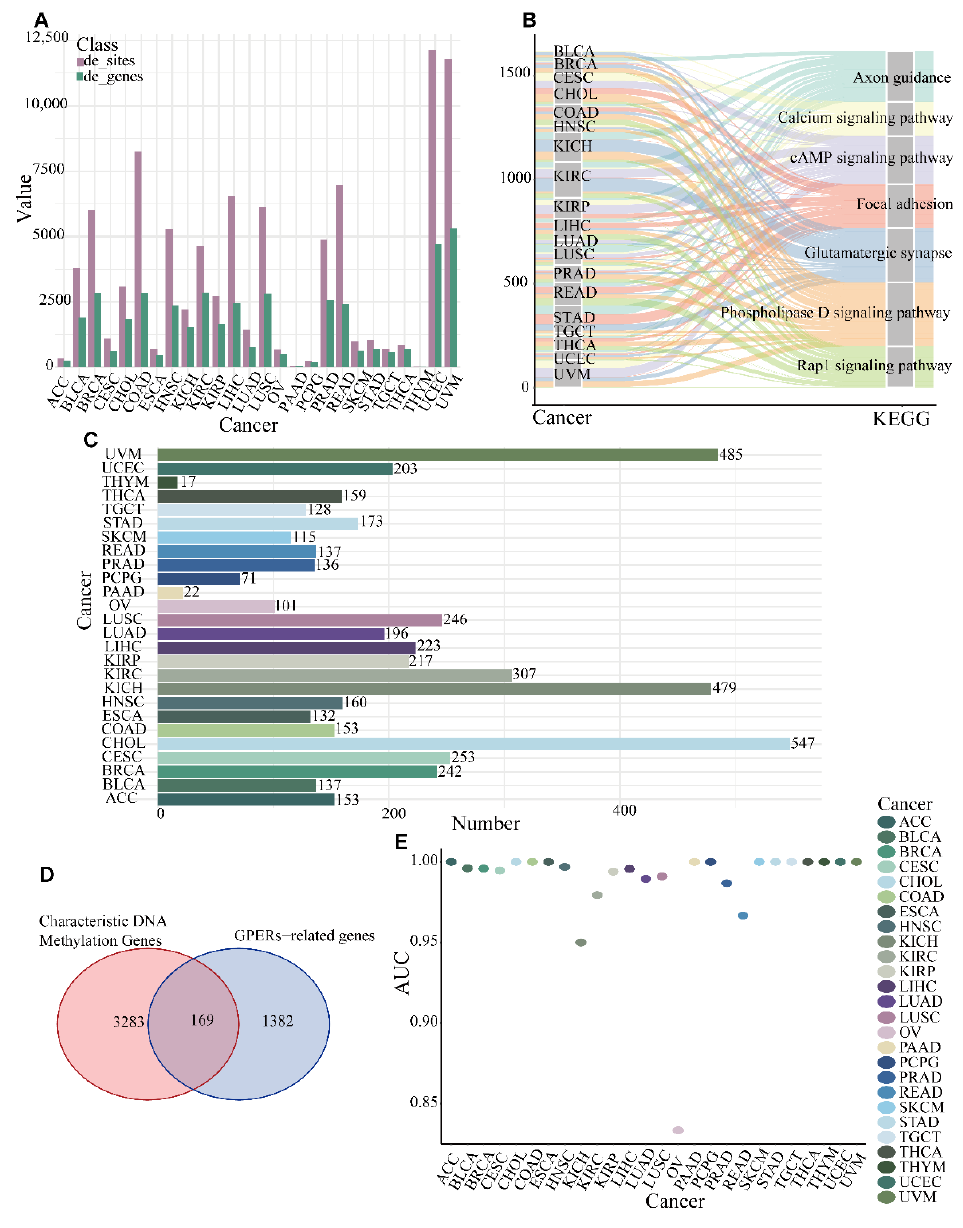
Figure 2. The acquisition of characteristic DNA methylation genes. ( A ) The number of differential DNA methylation sites/genes; ( B ) KEGG pathway of differential gene enrichment; ( C ) The number of characteristic DNA methylation genes by “Boruta” method in pan-cancer; ( D ) The intersection of characteristic DNA methylation genes and GPERs-related genes; ( E ) The AUCs of classification for cancer/non-cancer in pan-cancer.